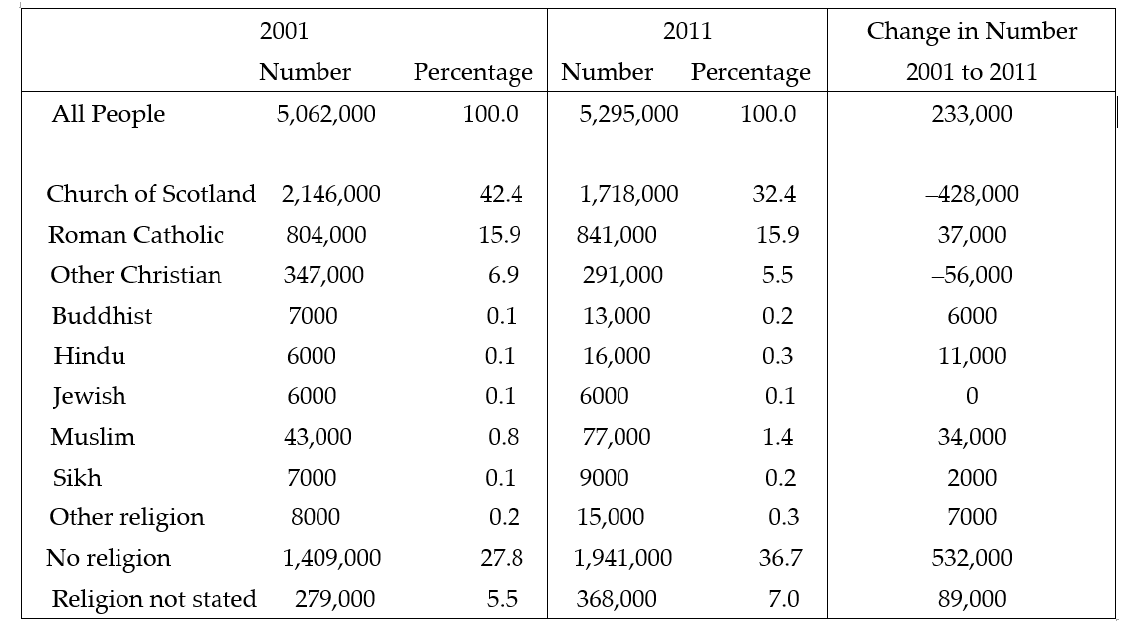
Figure 2. Religion in Scotland 2001 and 2011 (National Records for Scotland 2018).